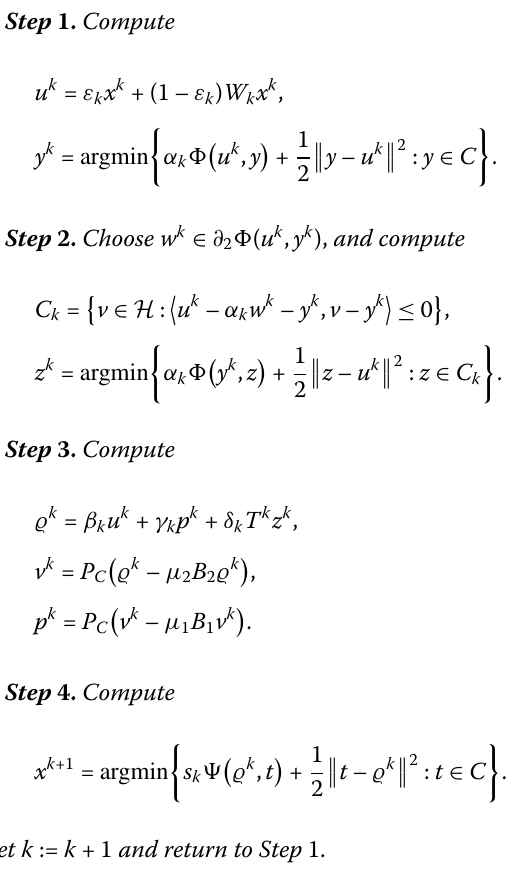
Algorithm 3.1 Initial step : Given x 1 ∈ C arbitrarily . The sequences { ε k } , { β k } , { γ k } , { δ k